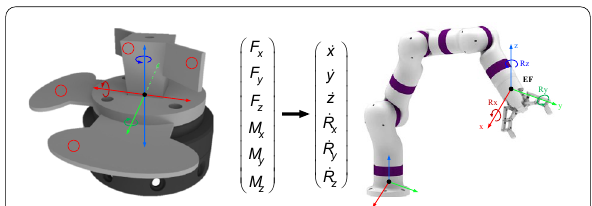
Figure 2 The mechanical design of the force-sensed joystick and the relationship between JF and EF